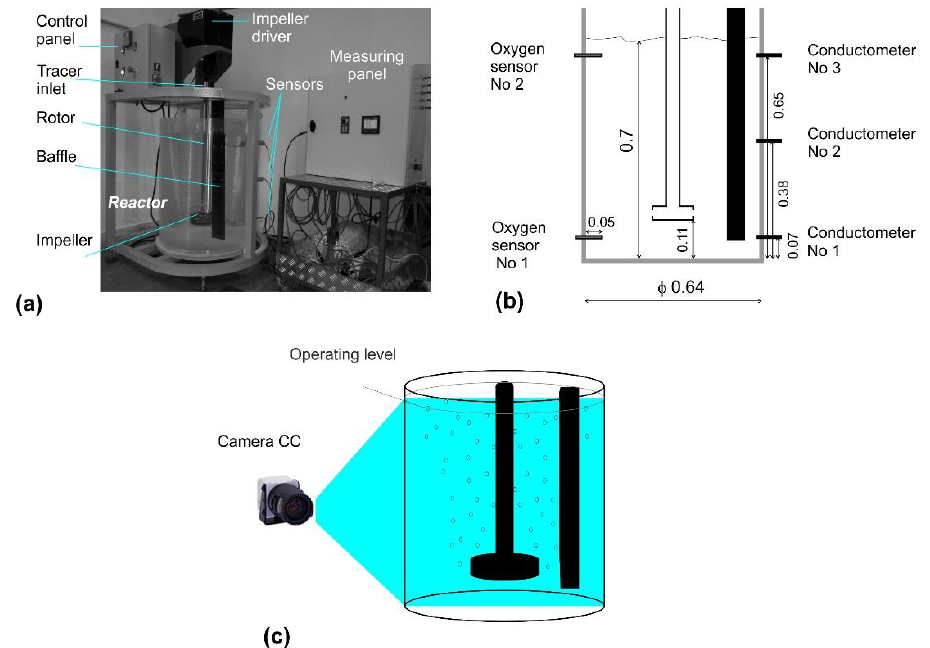
Figure 1. Physical modelling test stand: ( a ) View of the test stand with all elements; ( b ) a scheme of the refining model, with marked places of conductometers and fixed oxygen sensors, and the most important dimensions (in m) of the model; ( c ) the idea of measuring refining gas dispersion in the model reactor.